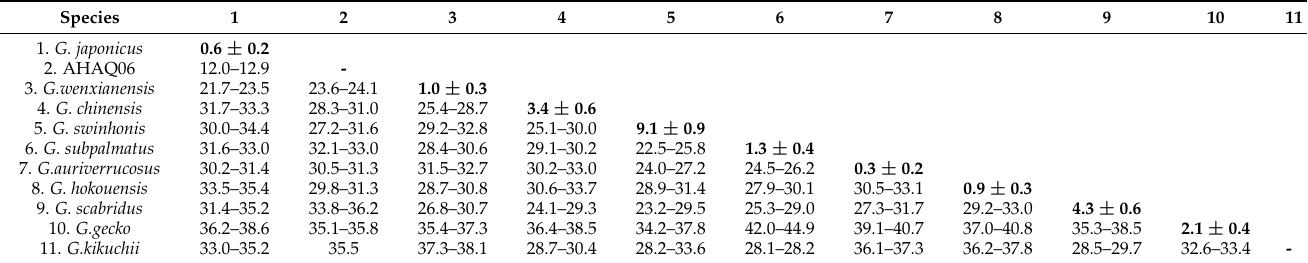
Table 1. Analysis of genetic distance within and between species of Chinese Gekko.